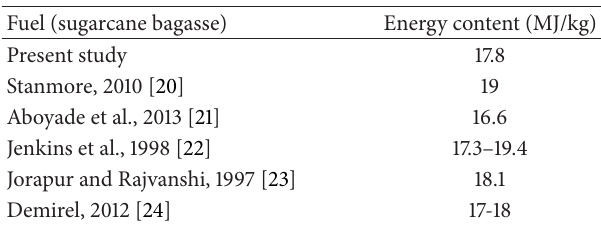
Table 3: Measure of the energy content of sugarcane bagasse from this study and from previous